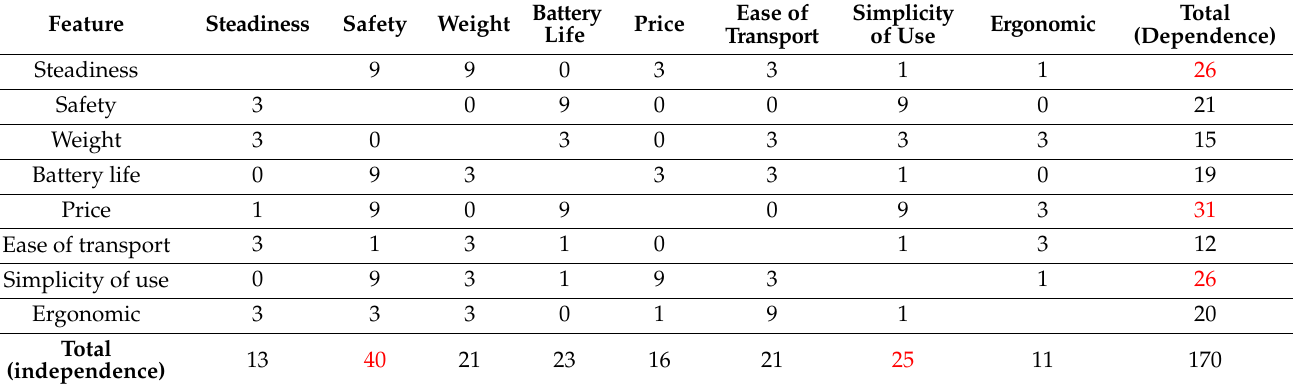
Table 5. Relationship Matrix of